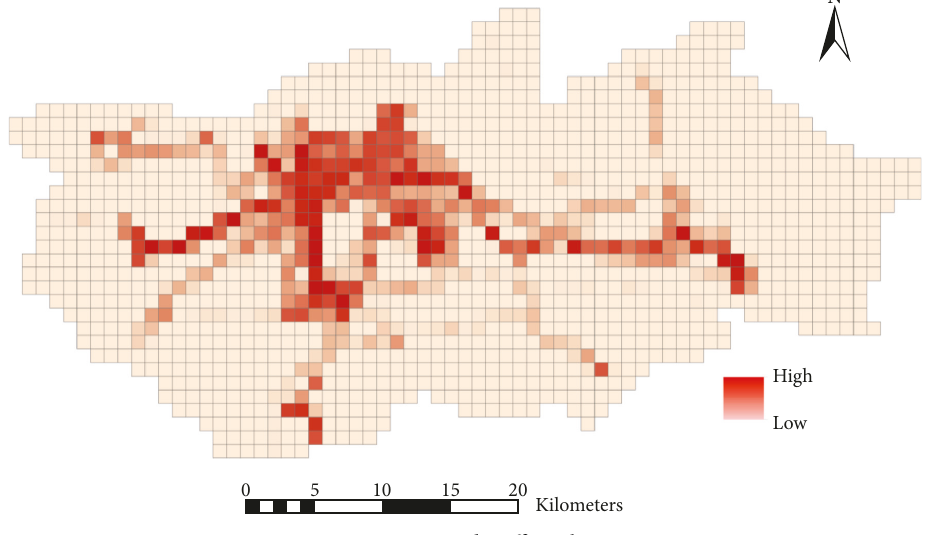
Figure 8: Road traffic